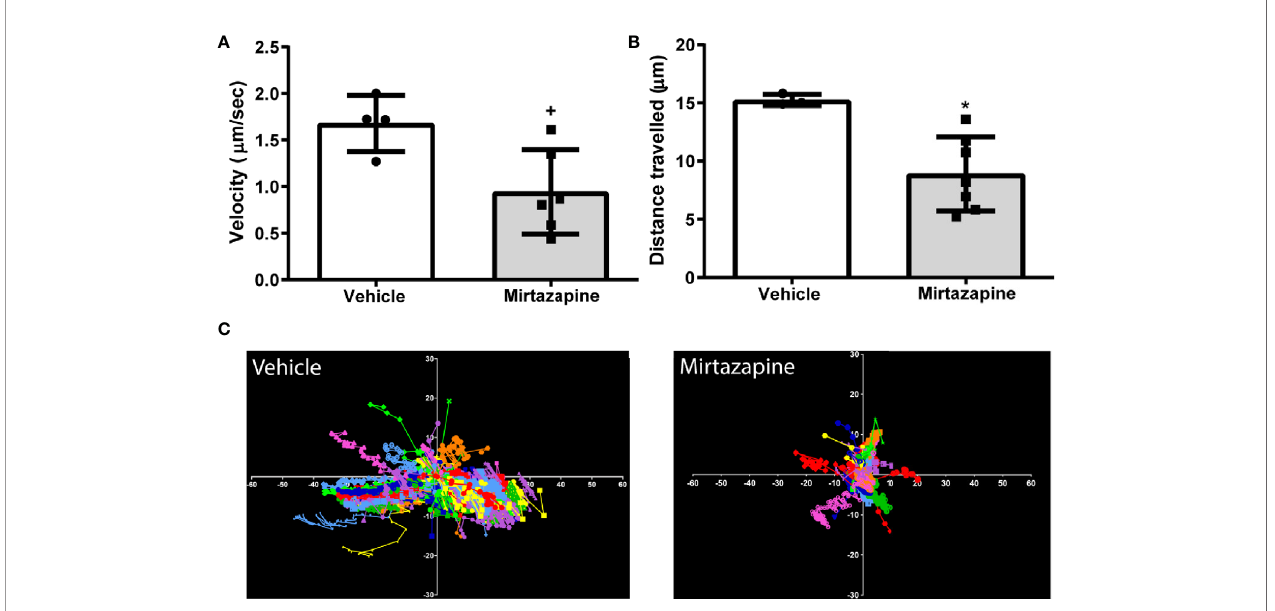
FIGURE 2 | Reduced sinusoidal patrolling activity of hepatic B cells after mirtazapine treatment. Mice were treated with mirtazapine or vehicle, and cell mobility parameters such as velocity and total distance traveled (the cumulative length of the trajectory) per cell were quanti fi ed from analyses of live cell imaging results. (A) Mean movement velocity of hepatic B cells and (B) average distance traveled by hepatic B cells. Data are shown as mean +/- SEM, Student ’ s t test + p ≤ 0.05, *p ≤ 0.02 n = 4/7mice/group. (C) Representative plots of B cell motion trajectories from one fi eld of view of vehicle or mirtazapine treated livers. Each vector represents displacement of an individual B cell for an imaging period of >5 min relative to their starting